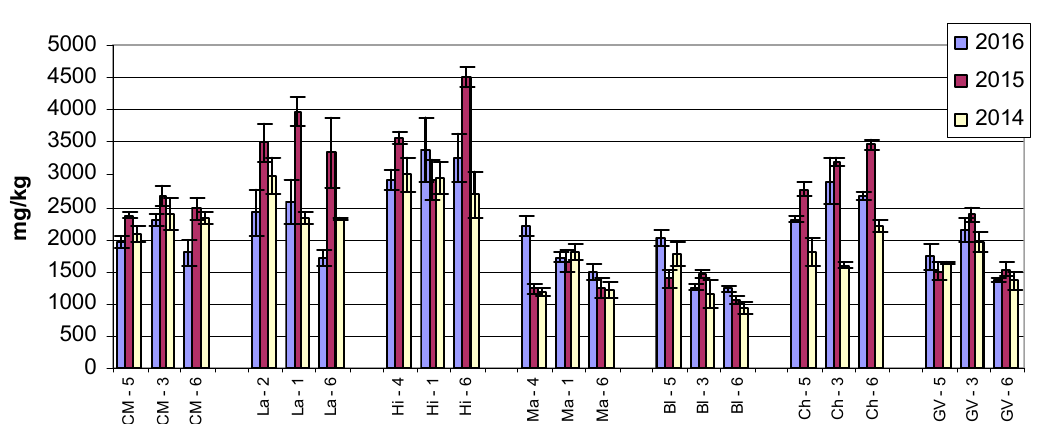
Figure 2. Contents of trans - ε -viniferin in grape canes during three years. Example explanation of abbreviations: CM-5—“CM” is the variety, “5” is the sampling site (see Materials and Methods and Table 1).